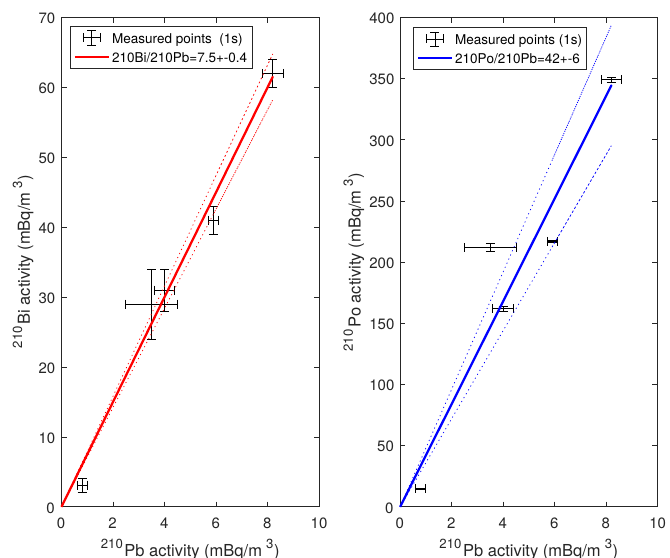
Figure 3. Volumic activities in the plume. Bars represent one sigma errors and are derived from the uncertainty of radioactivity analysis. Full lines represent the linear regression between the points and the origin, and dotted lines represent two sigma standard error on the slope of the regression